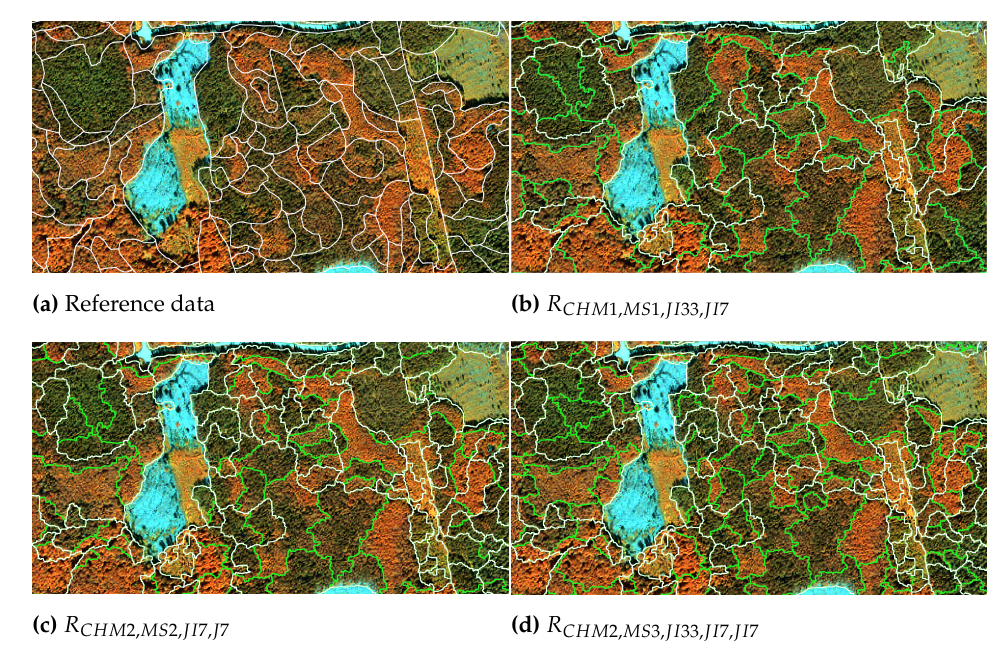
Figure 6. Example of segmentation results using JSEG workflow with multispectral information added (56.51 ◦ N, 24.96 ◦ E: 56.51 ◦ N, 24.97 ◦ E, notation is described in section 2.3.1.). The white line denotes CHM segmentation results, but the green one denotes the lines added during multispectral data processing. Background layer: GeoEye-1 satellite image (NIR, G and B bands).